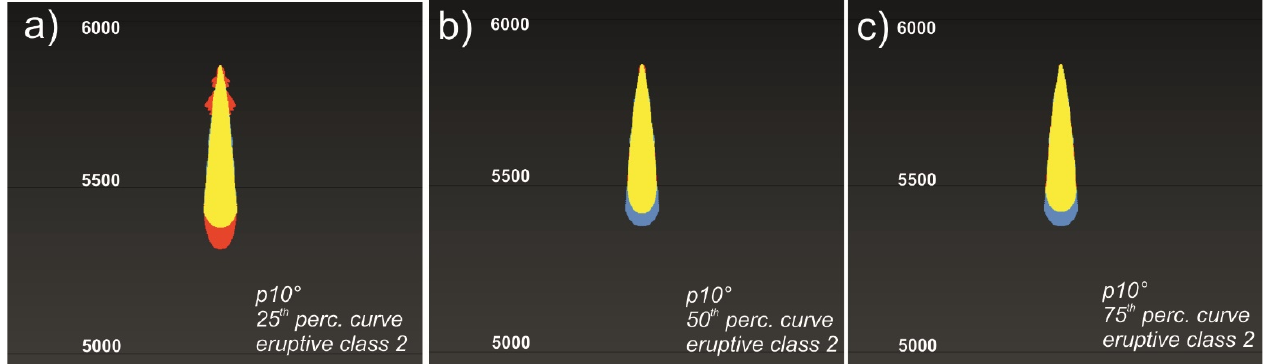
Figure 11. Graphical representation of the fitness value, overlaying test simulations obtained by using the 25th ( a ), 50th ( b ) and 75th ( c ) percentile curves associated to the eruptive class 2, with emplacements produced by using bell-shaped curve for the same eruptive class used as a reference. Yellow represents the common inundated areas, red represents the overestimated areas (inundation from tests but not from the reference) and blue represents the underestimated areas (inundation from the reference but not from the tests). The lava flow originating from the 25th percentile curve show small lateral overflows due to cooling effects during the waning phase.